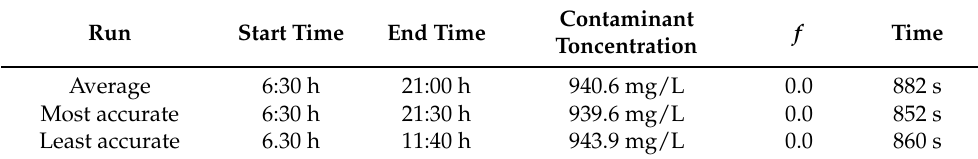
Figure 11. Network node locations of the two top candidate source nodes 251 and 260 (zoomed in part of the network). Table 6. Framework 1 results for the Richmond network for the source node 251.